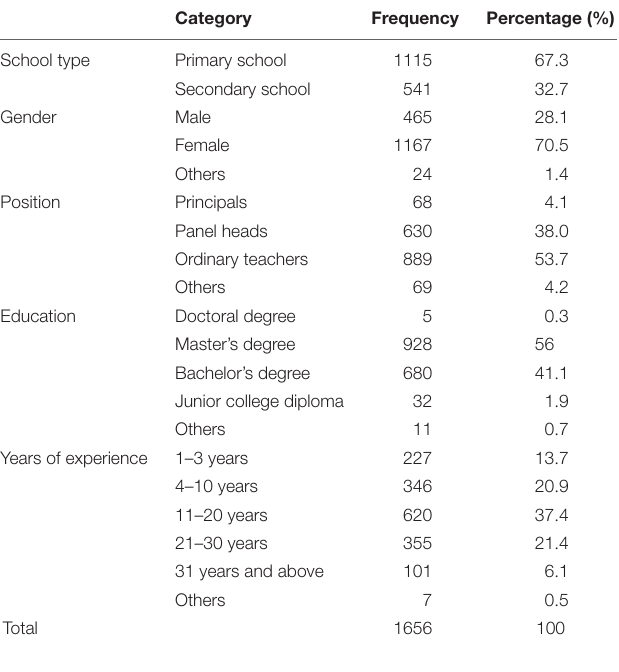
889 (53.7%) were regular teachers, and 69 (4.2%) did not specify their positions. In terms of their educational backgrounds, most reported a bachelor’s (680 participants, 41.1%) or master’s degree (928 participants, 56.0%). Table 1 summarizes these demographic factors in